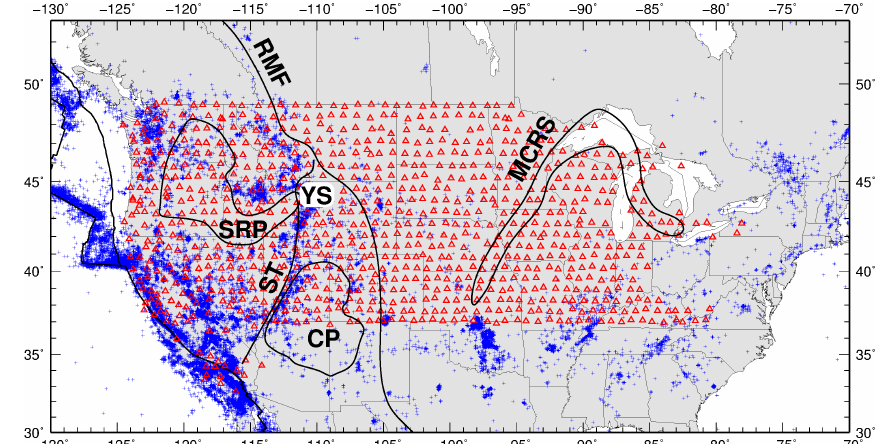
Figure 1. Map of North America with seismic stations (triangles) from USArray (http://www.usarray.org/researchers/obs/transportable), the Berkeley Seismological Lab (https://seismo.berkeley.edu), the Southern California Seismic Network (http://www.scsn.org), and the perma- nent network of the US Geological Survey (http://earthquake.usgs.gov/monitoring/anss/). The data were obtained from the IRIS data archive (http://ds.iris.edu/data/). Seismicity (blue crosses) and relevant geological units are marked (RMF – Rocky Mountain Front, SRP – Snake